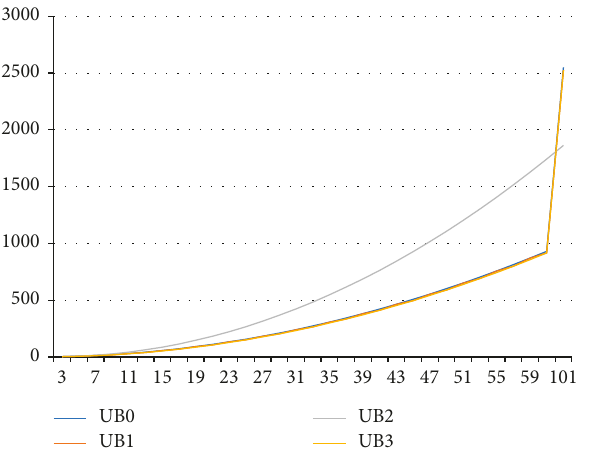
Figure 4: Comparison among UB0, Ub1, UB2, and UB3 for the radio number of double triangular snake.